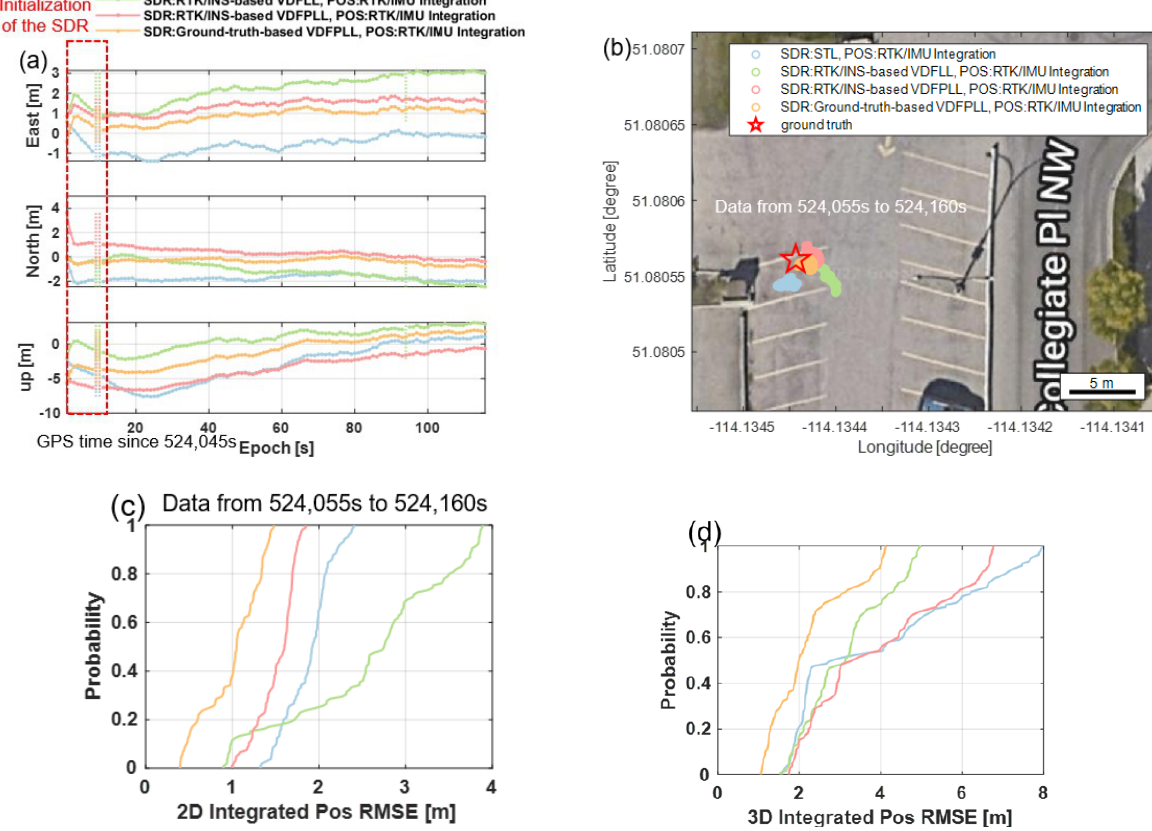
Figure 14. RTK/INS integration position results and statistical analysis of different SDRs where dashed lines correspond to the outlier epochs in the semi-open-sky situation. ( a ) RTK/INS integration position error ( b ) horizontal RTK/INS integration position results in Google Map ( c ) CDF curves of 2D RTK/INS integration position RMSE ( d ) CDF curves of 3D RTK/INS integration position